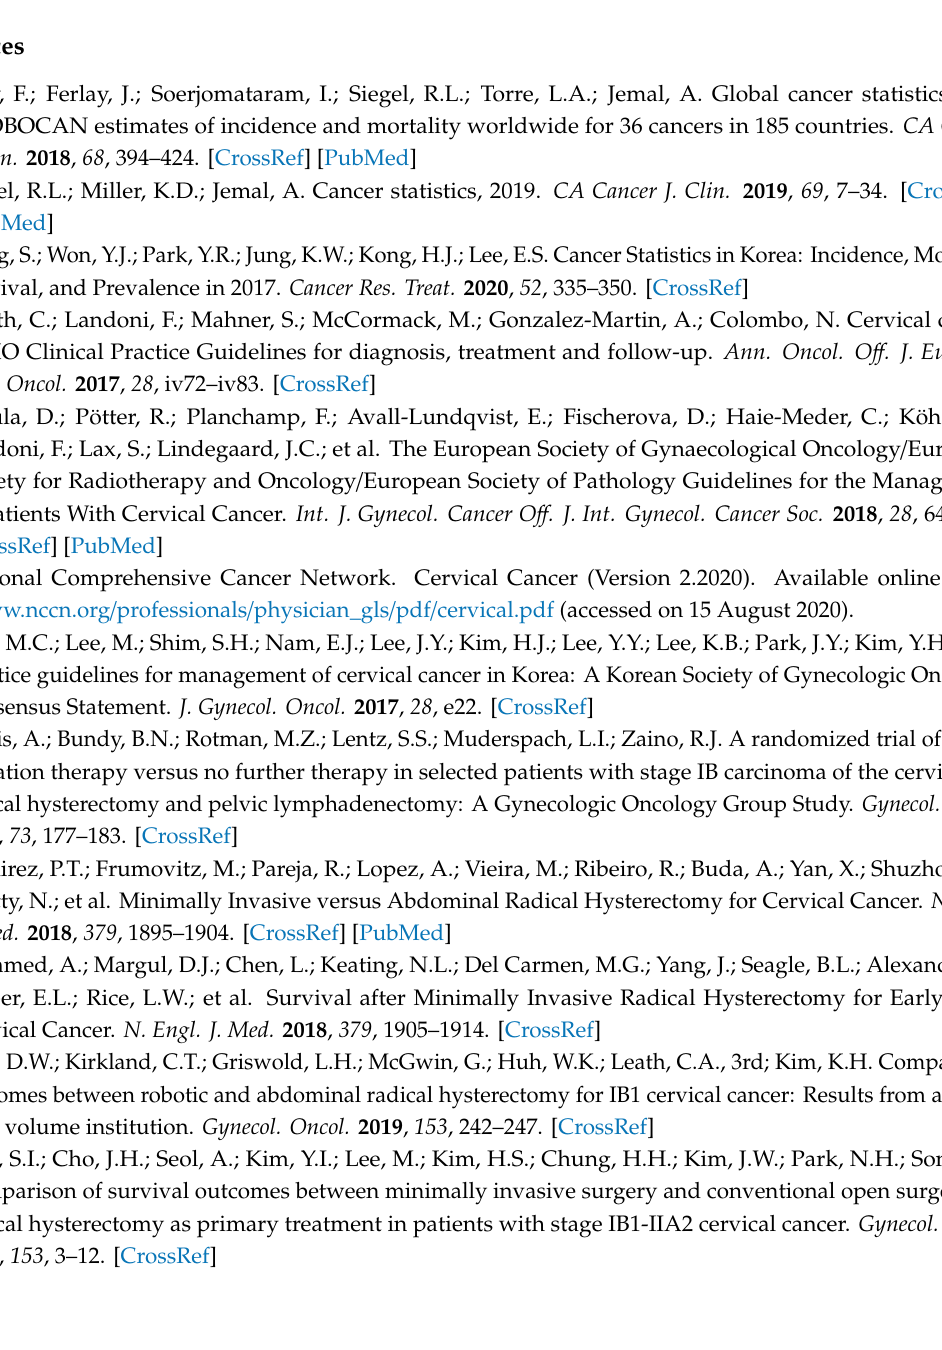
Figure S1: Correlation between the guideline adherence rate and MIS RH rate, Table S1: Patients’ clinicopathologic characteristics according to surgical approach, Table S2: Recurrence patterns and final status of recurred patients, Table S3: Minimally invasive surgery rate and guideline adherence rate by gynecologic